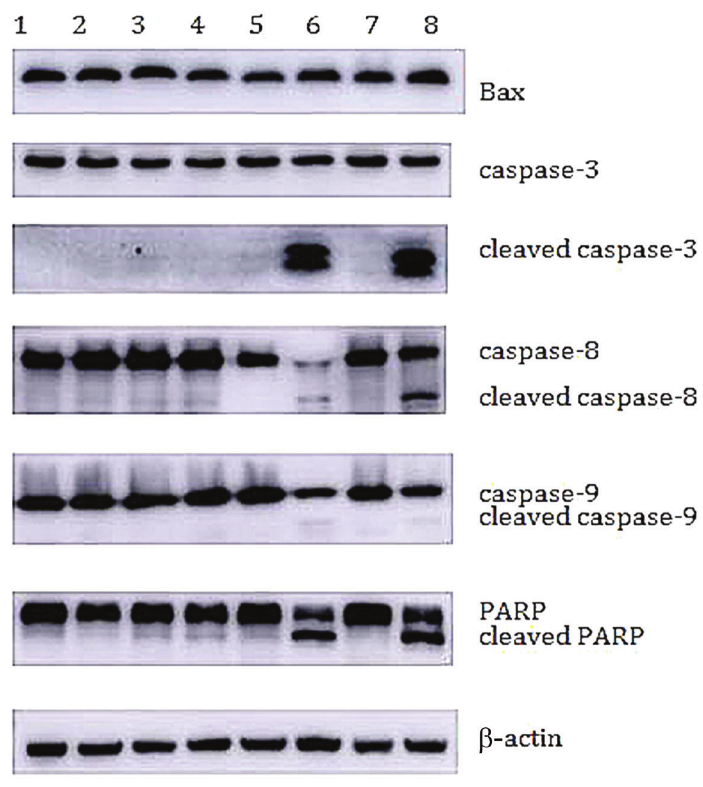
Figure 4. Effects of the A88V and G11R mutants on apoptosis-related proteins in HaCat cells as- sessed by western blotting analysis. + / – DOX: with or without doxycycline. Lanes : 1 : NC( – DOX); 2 : NC ( + DOX); 3 : WT( – DOX); 4 : WT( + DOX); 5 : A88V ( – DOX); 6 : A88V( + DOX); 7 : G11R( – DOX); 8 : G11R( +